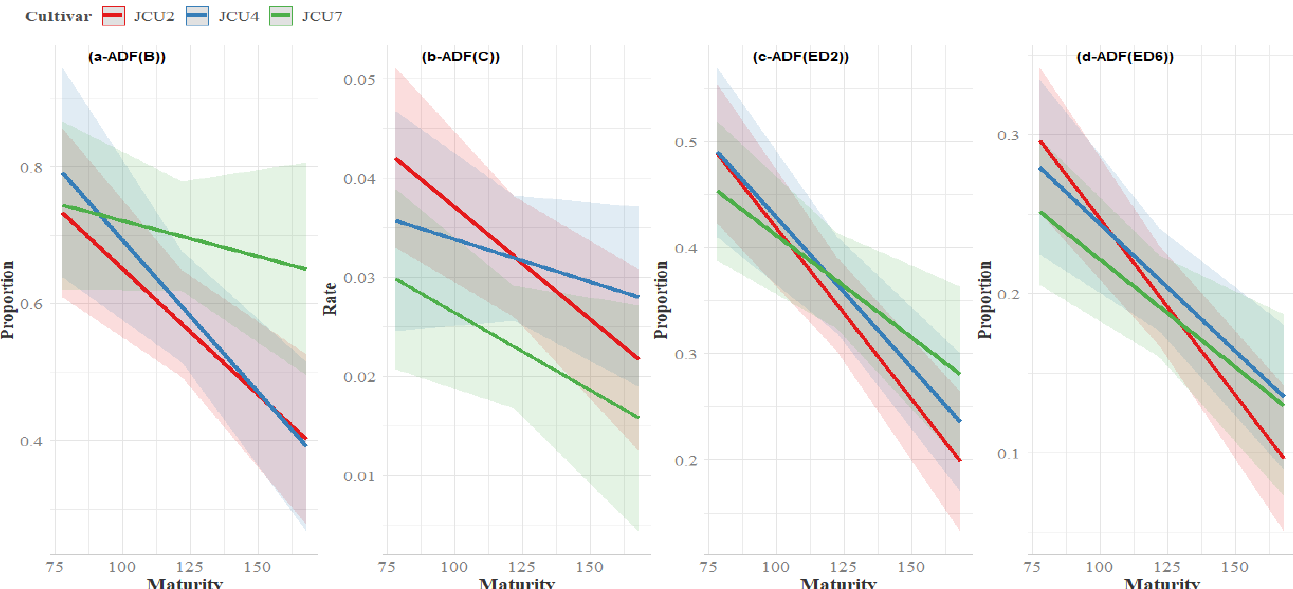
Figure 7. Effect plots for the change in in situ acid detergent fibre (ADF) degradation of D. virgatus (JCU2), D. bicornutus (JCU4) and D. leptophyllus (JCU7) with maturity. ( a ) B; potentially degradable fraction, ( b ) C; rate of degradation of fraction B, ( c ) ED2; effective ADF degradability with particle outflow rate of 2%/h and ( d ) ED6; effective ADF degradability with particle outflow rate of 6%/h. Cultivar by maturity interactions were not significant ( p < 0.14).